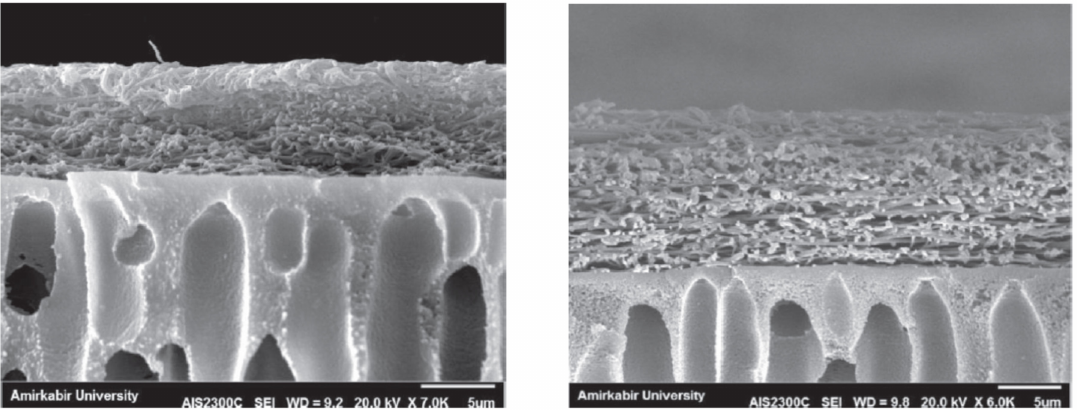
Figure 19. SEM cross-sectional image of chitosan/PVA/PES-a-Fe 3 O 4 dual layer nanofibrous membranes for adsorption- filtration of Cr(VI) and Pd(II). Reprinted from [181] with permission from